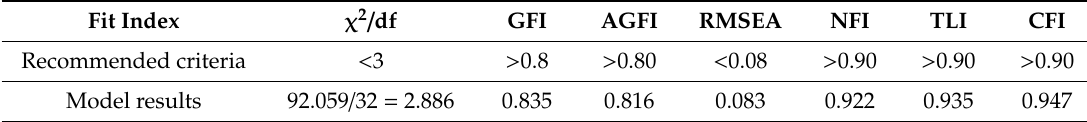
Table 4. Goodness-of-fit indices of KSFs measurement model.